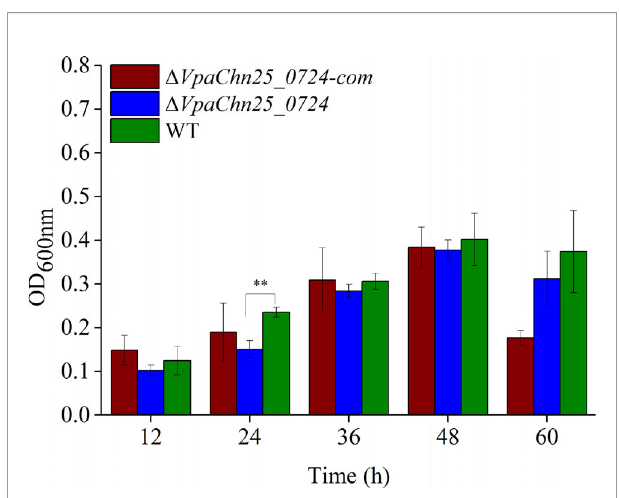
FIGURE 4 | Bio fi lm formation of V. parahaemolyticus CHN25 (WT), D VpaChn25_0724 , and D VpaChn25_0724 -com strains. The strains were incubated in the TSB medium at 37°C under static conditions. WT: wild type. **p<0.01 compared with the WT.